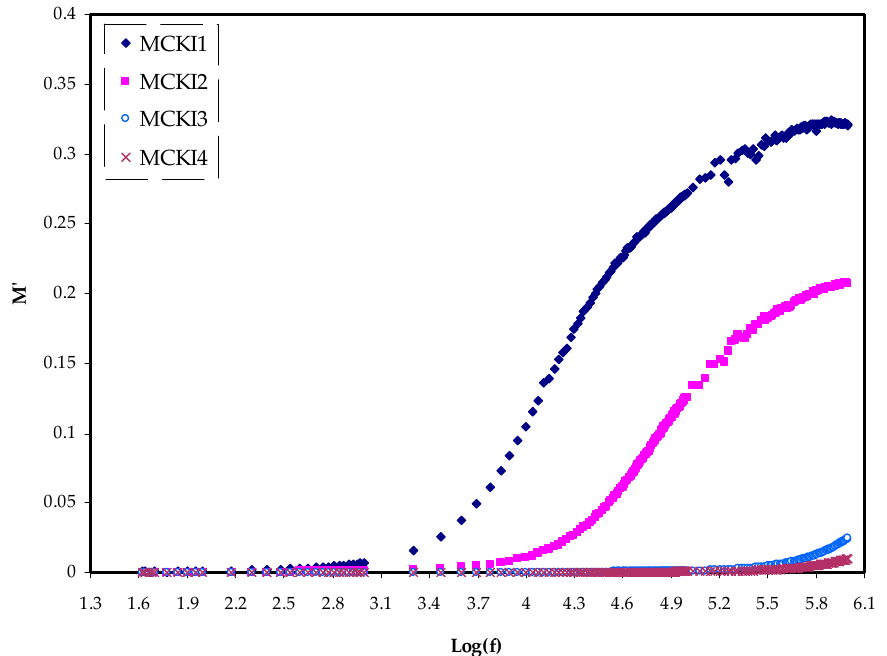
Figure 6. Electric modulus plot of M r against log(f)for the MCKI samples.